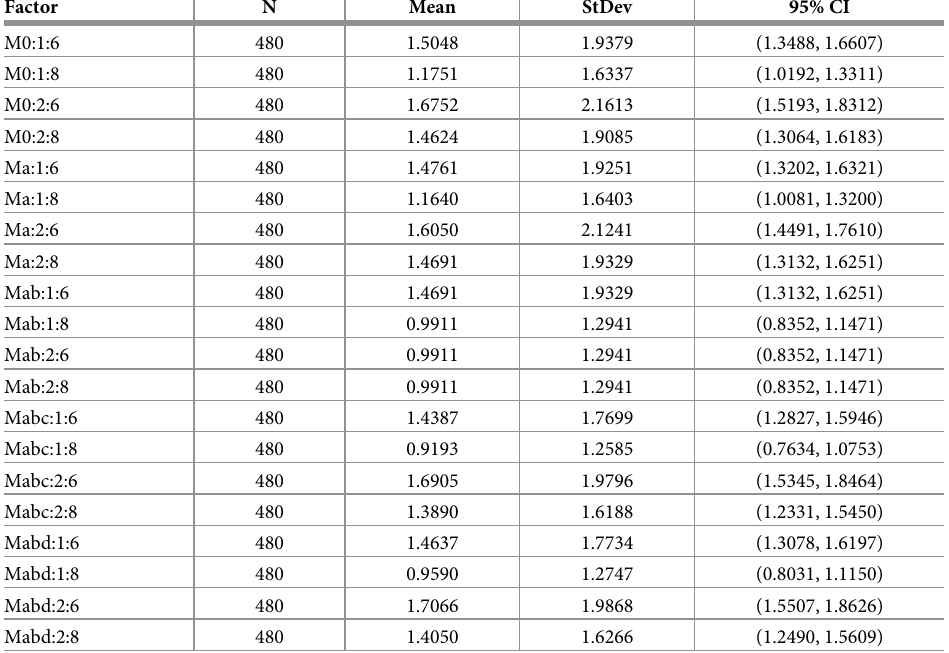
Table 8. Waiting time results.